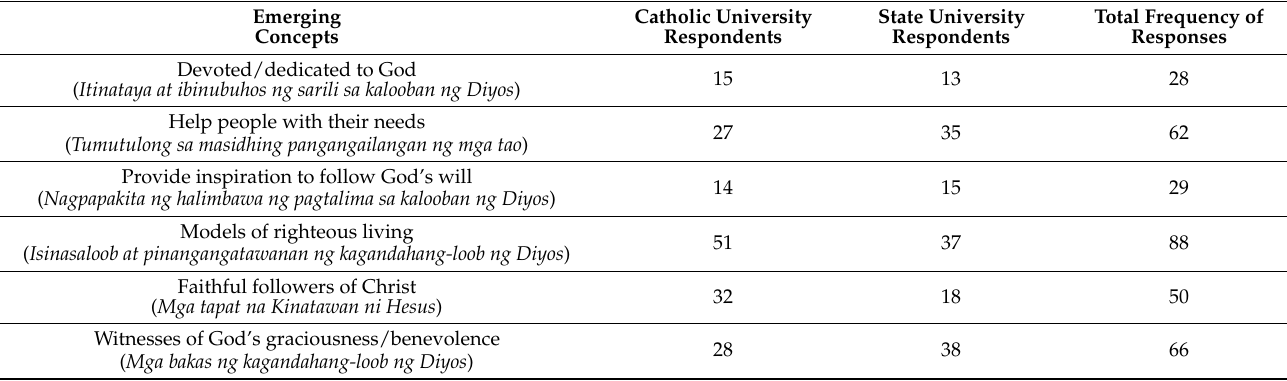
Table 1. Tabulation of Responses on the Perspectives of the